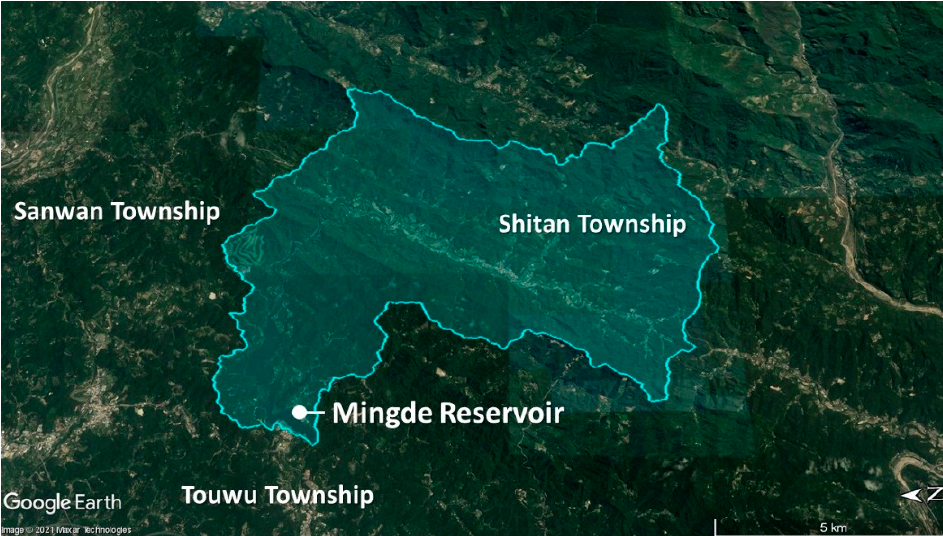
Figure 2. Location of Mingde Reservoir (including water catchment area).